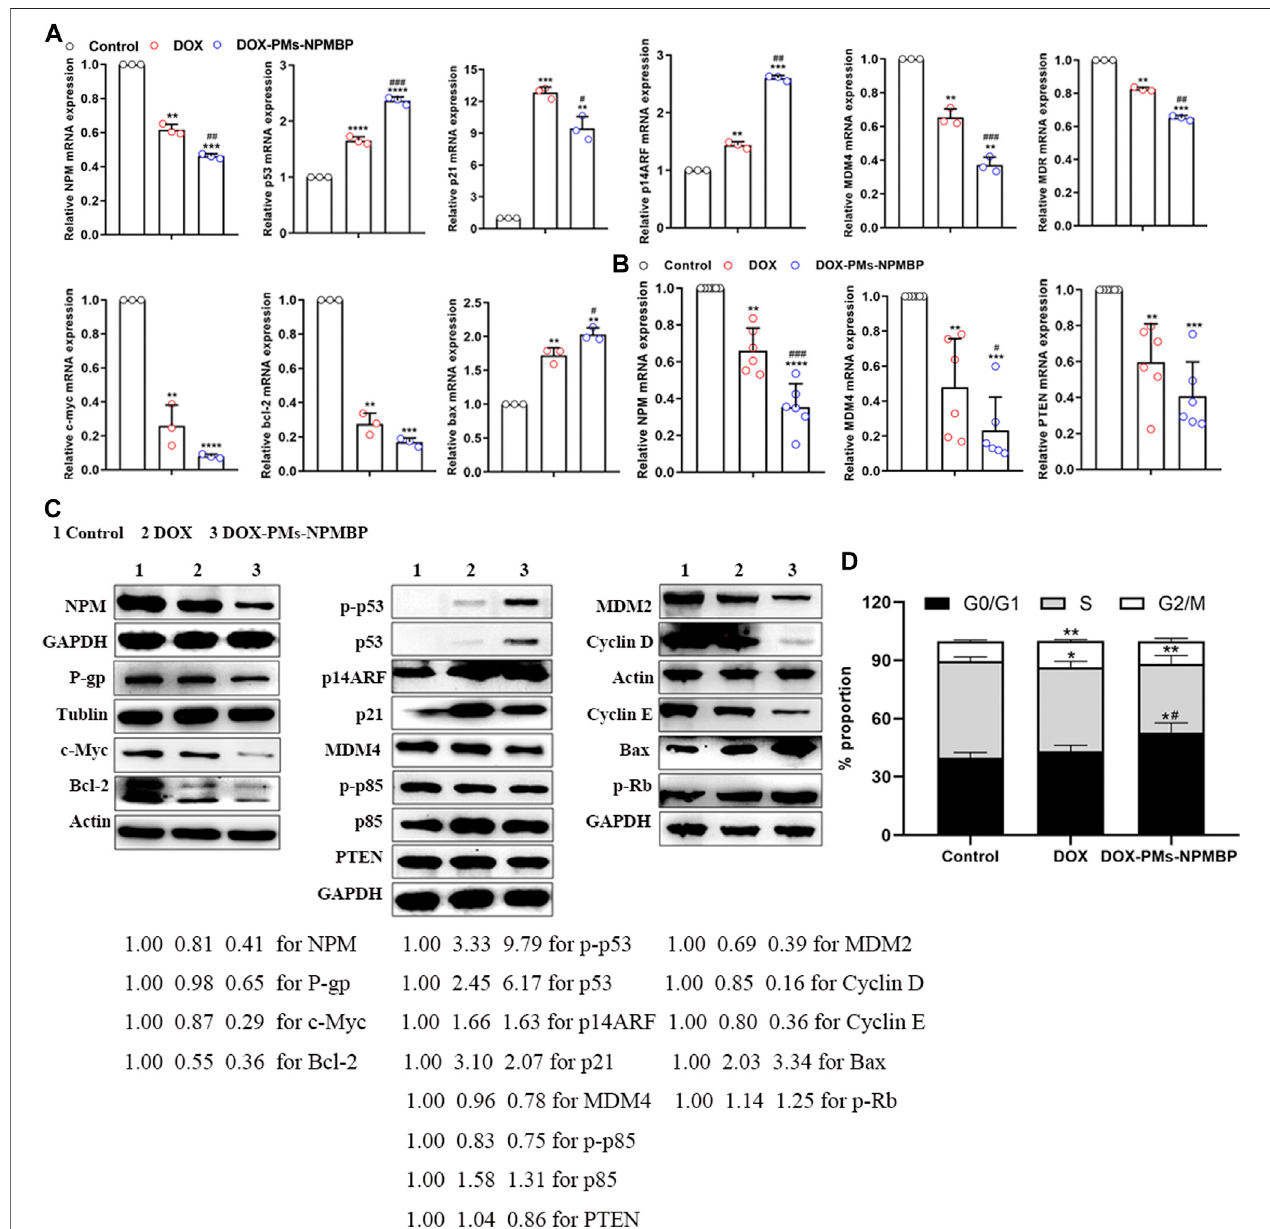
FIGURE 5 | Effects of DOX-PMs-NPMBP on mRNA and protein expression levels, and cell cycle distribution. Nalm6/DOX cells (A) and primary ALL cells from patients (B) were treated with DOX or DOX-PMs-NPMBP for 12 h, cells were harvested, and total RNA was isolated. Real-time PCR analysis was performed. All assays were repeated three times. ** p < 0.01, *** p < 0.001, **** p < 0.0001 compared with control, # p < 0.05, ## p < 0.01, ### p < 0.001 compared with DOX. (C) Protein expression levelsintheNalm6/DOX cellstreatedwithDOXorDOX-PMs-NPMBPfor24 hasmeasuredbywesternblotting.Tublin,ActinorGAPDHwasemployed as an internal reference. The experiments were repeated at least three times. The intensity of different protein bands was quanti fi ed and normalized with GAPDH, Tublin or Actin. Changes in protein expression levels are represented as percentage change from untreated control levels, which were set to 100% (1.00). (D) Cell